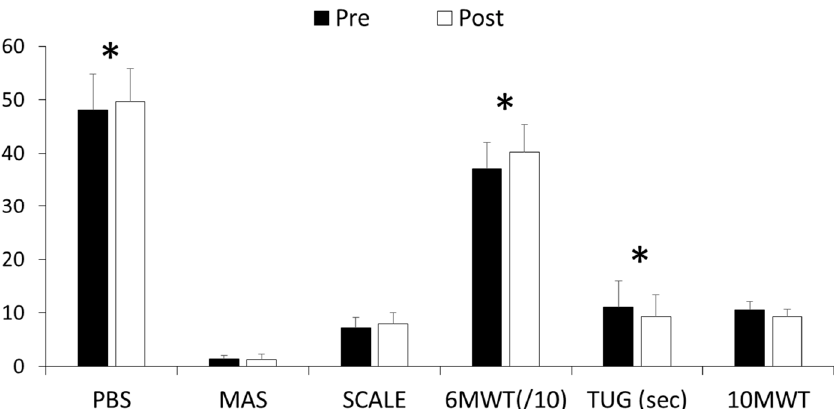
Figure 5. Clinical outcomes before and after training in children with CP. (*) indicates significant difference (p < 0.05). Table 3. Clinical evaluation among the children with CP between pre and post training. Outcome Measures